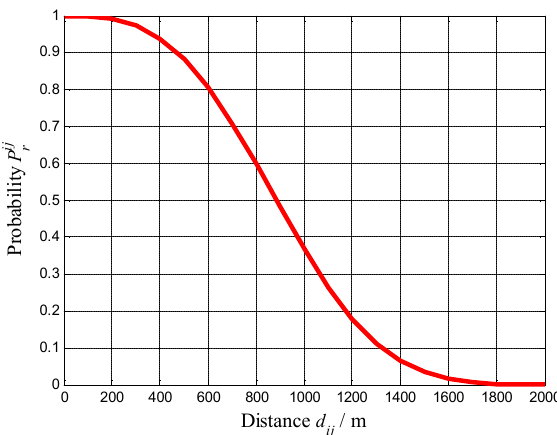
Figure 2. The probability of a successful transmission vs. distance, as determined by Equation (11) for the parameters listed in Table 1. The parameters of the realistic wireless communication model.